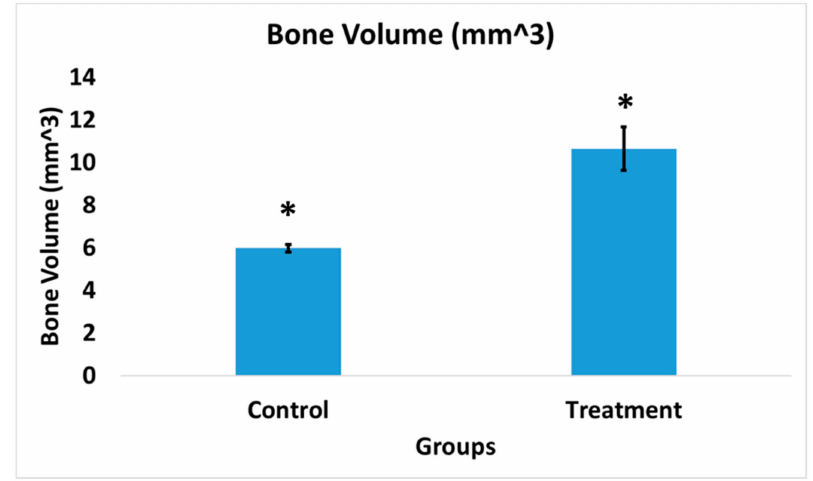
Figure 7. Bone volume in the infection control group of drill-hole model was significantly lower compared to the treatment group; n = 3 (control), n = 2 (treatment) * p <